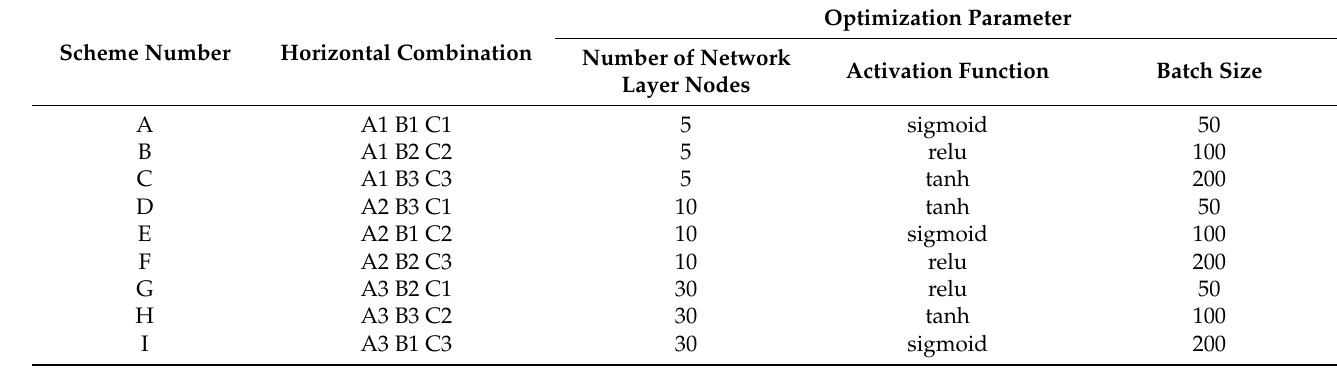
Table 5. The schemes of the orthogonal